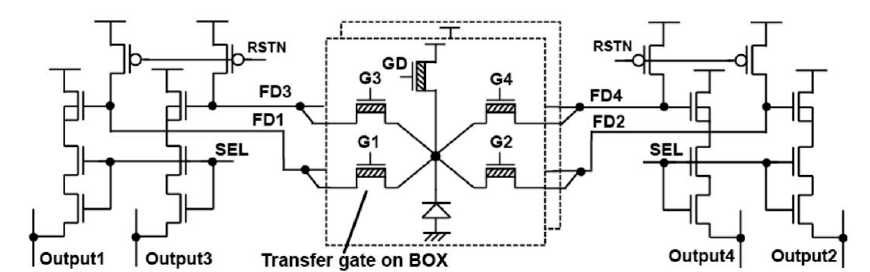
Figure 2. An equivalent circuit schematic of the developed pixel.